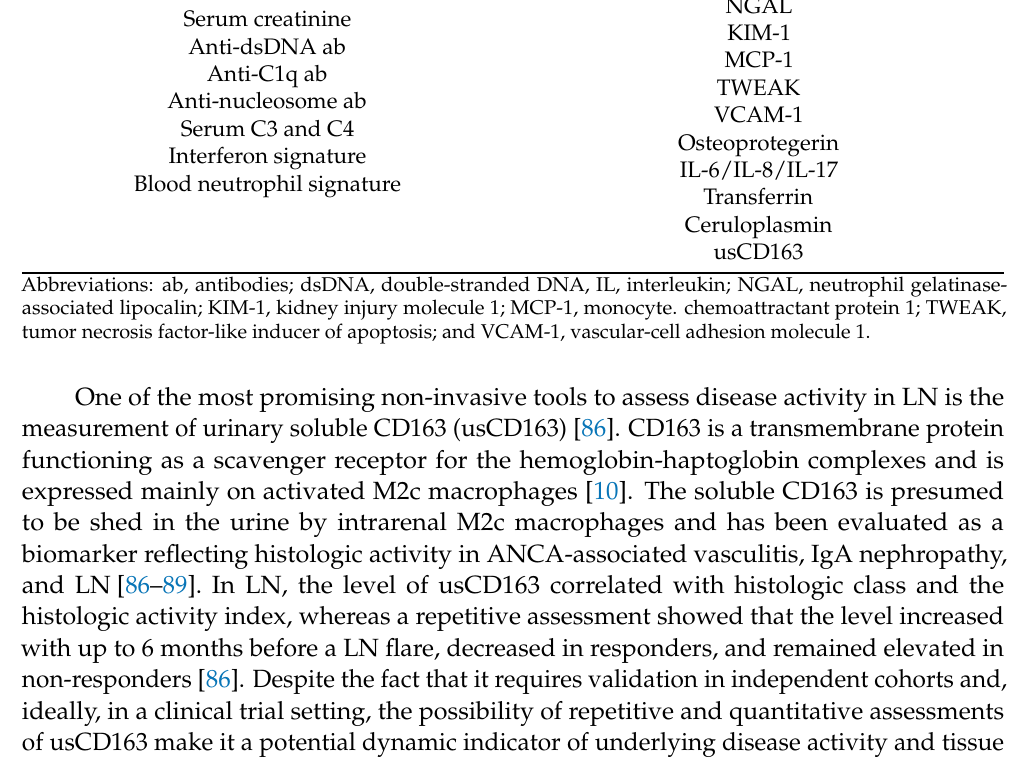
Serum creatinine Anti-dsDNA ab Anti-nucleosome ab Serum C3 and C4 Interferon signature Blood neutrophil signature